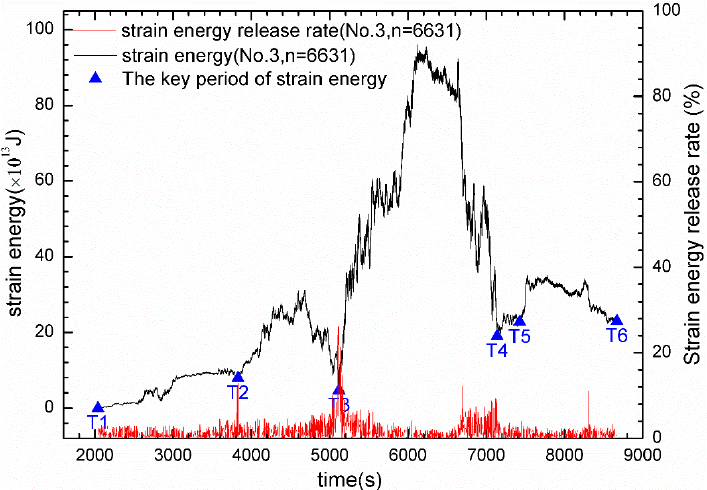
Figure 22. Strain energy release rate during the formation and evolution of normal fault.